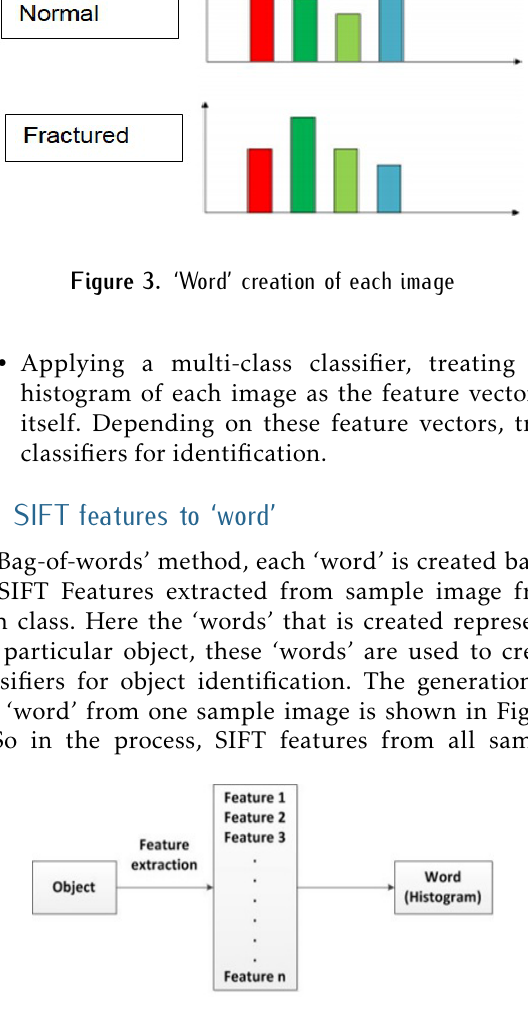
Figure 4. The process of ‘word’ generation in ‘Bag-of-Words’